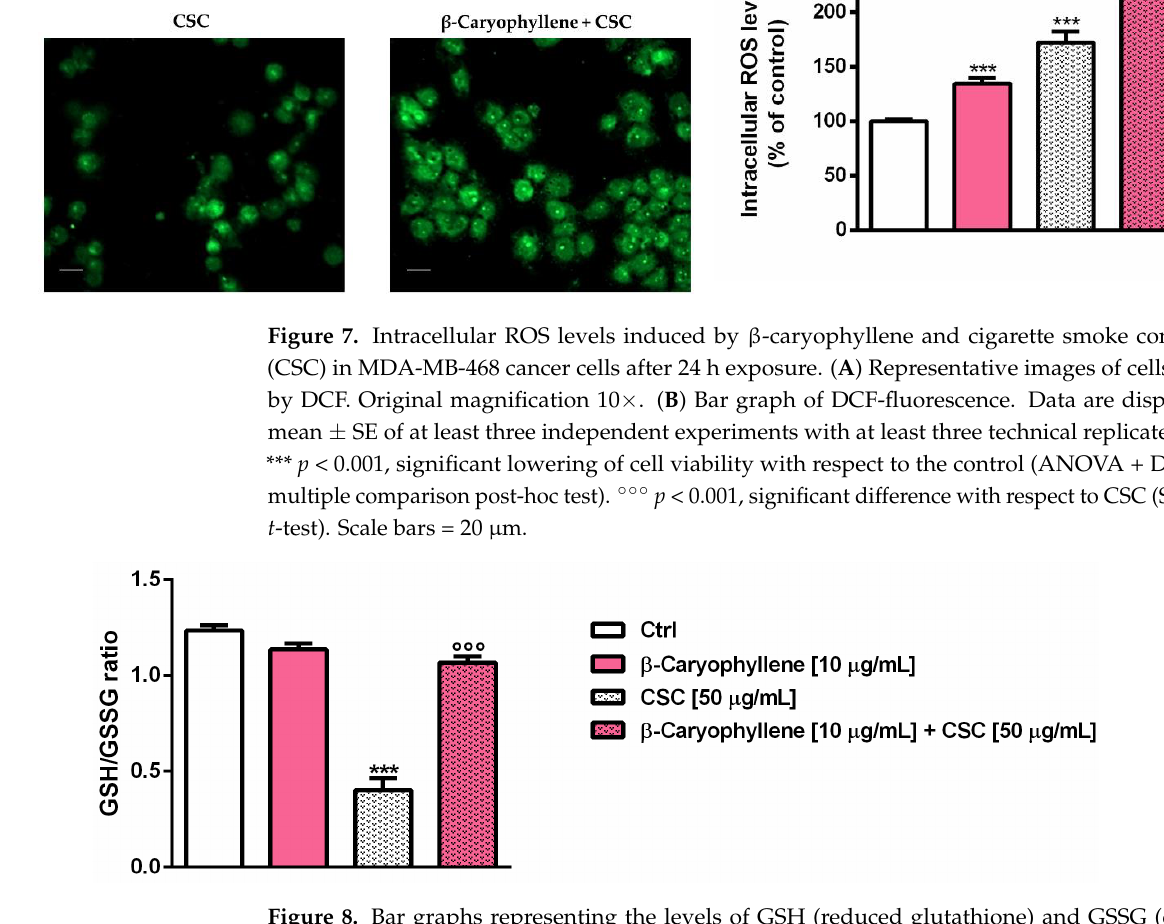
Figure 8. Bar graphs representing the levels of GSH (reduced glutathione) and GSSG (oxidized glutathione) induced by β -caryophyllene and cigarette smoke condensate (CSC) in MDA-MB-468 cancer cells after 24 h exposure as revealed by HPLC analysis. Data are displayed as mean ± SE of at least three independent experiments with at least two technical replicates ( n = 6). *** p < 0.001, significant lowering of cell viability with respect to the control (ANOVA + Dunnett’s multiple comparison post-hoc test). ◦◦◦ p < 0.001, significant difference with respect to CSC (Student’s t -test).